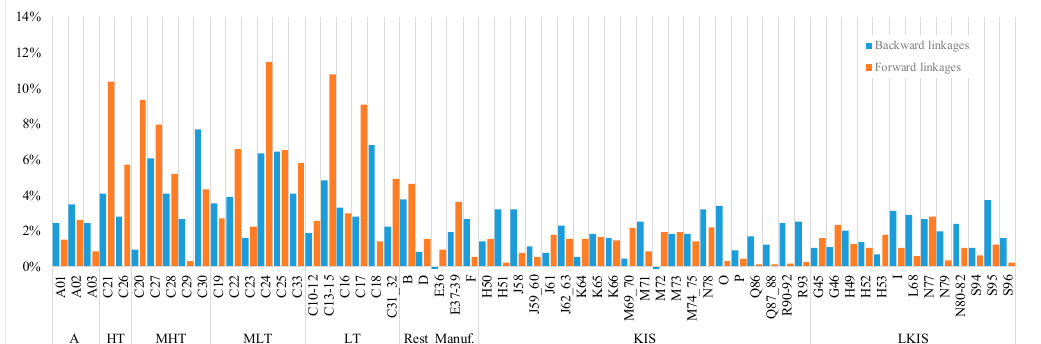
Figure 5. The impact of restructuring on the backward and forward linkages of the Czech economy. The horizontal axis shows the sectors of economic activity, and the vertical axis shows the percentage changes of the examined measure. The color of the bars represents the examined measure, as shown in the legend.